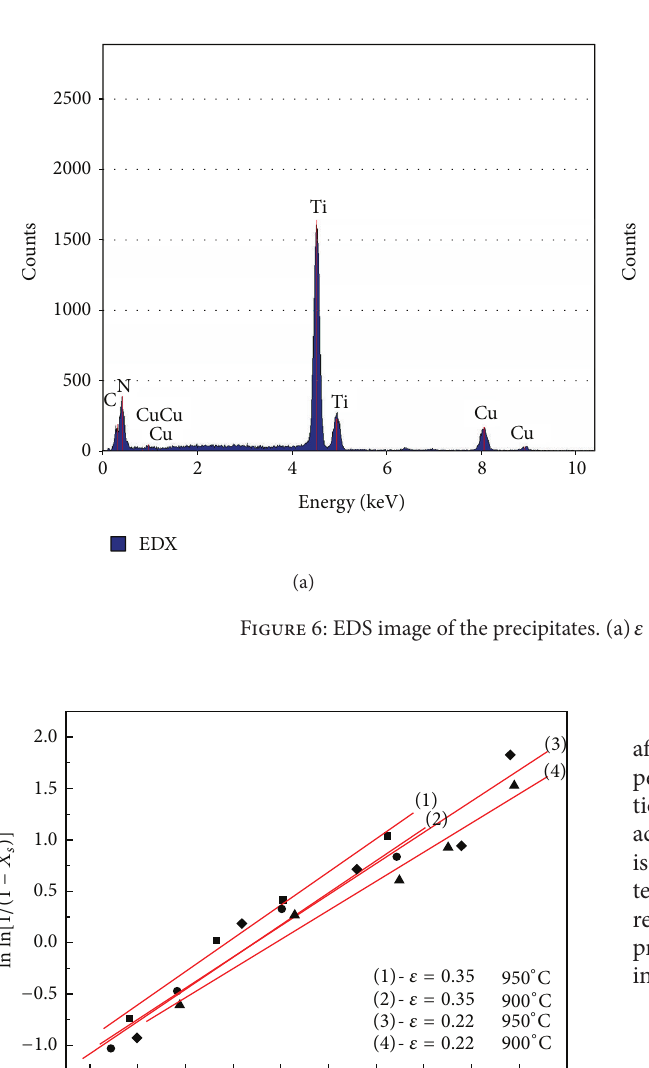
The static recrystallization kinetic equation is